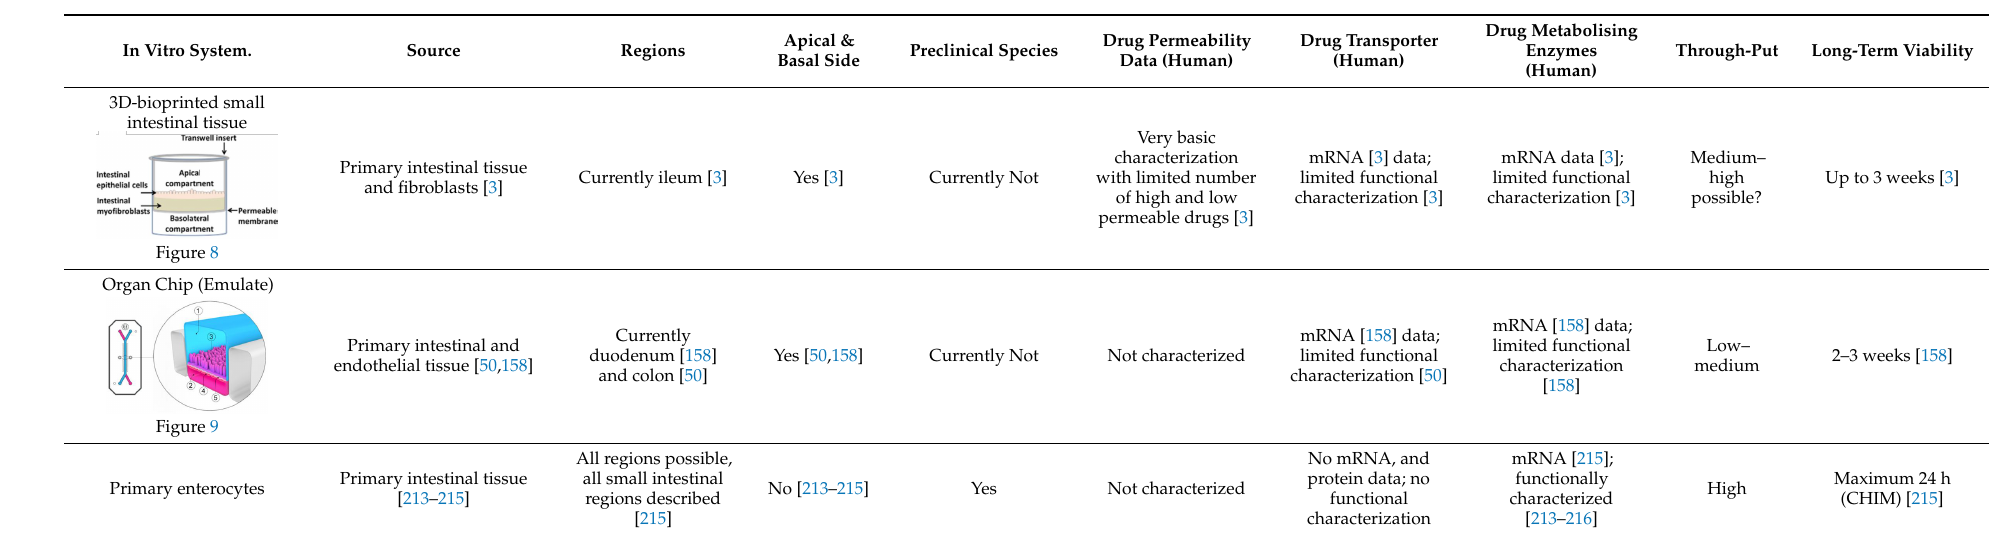
In Vitro System.